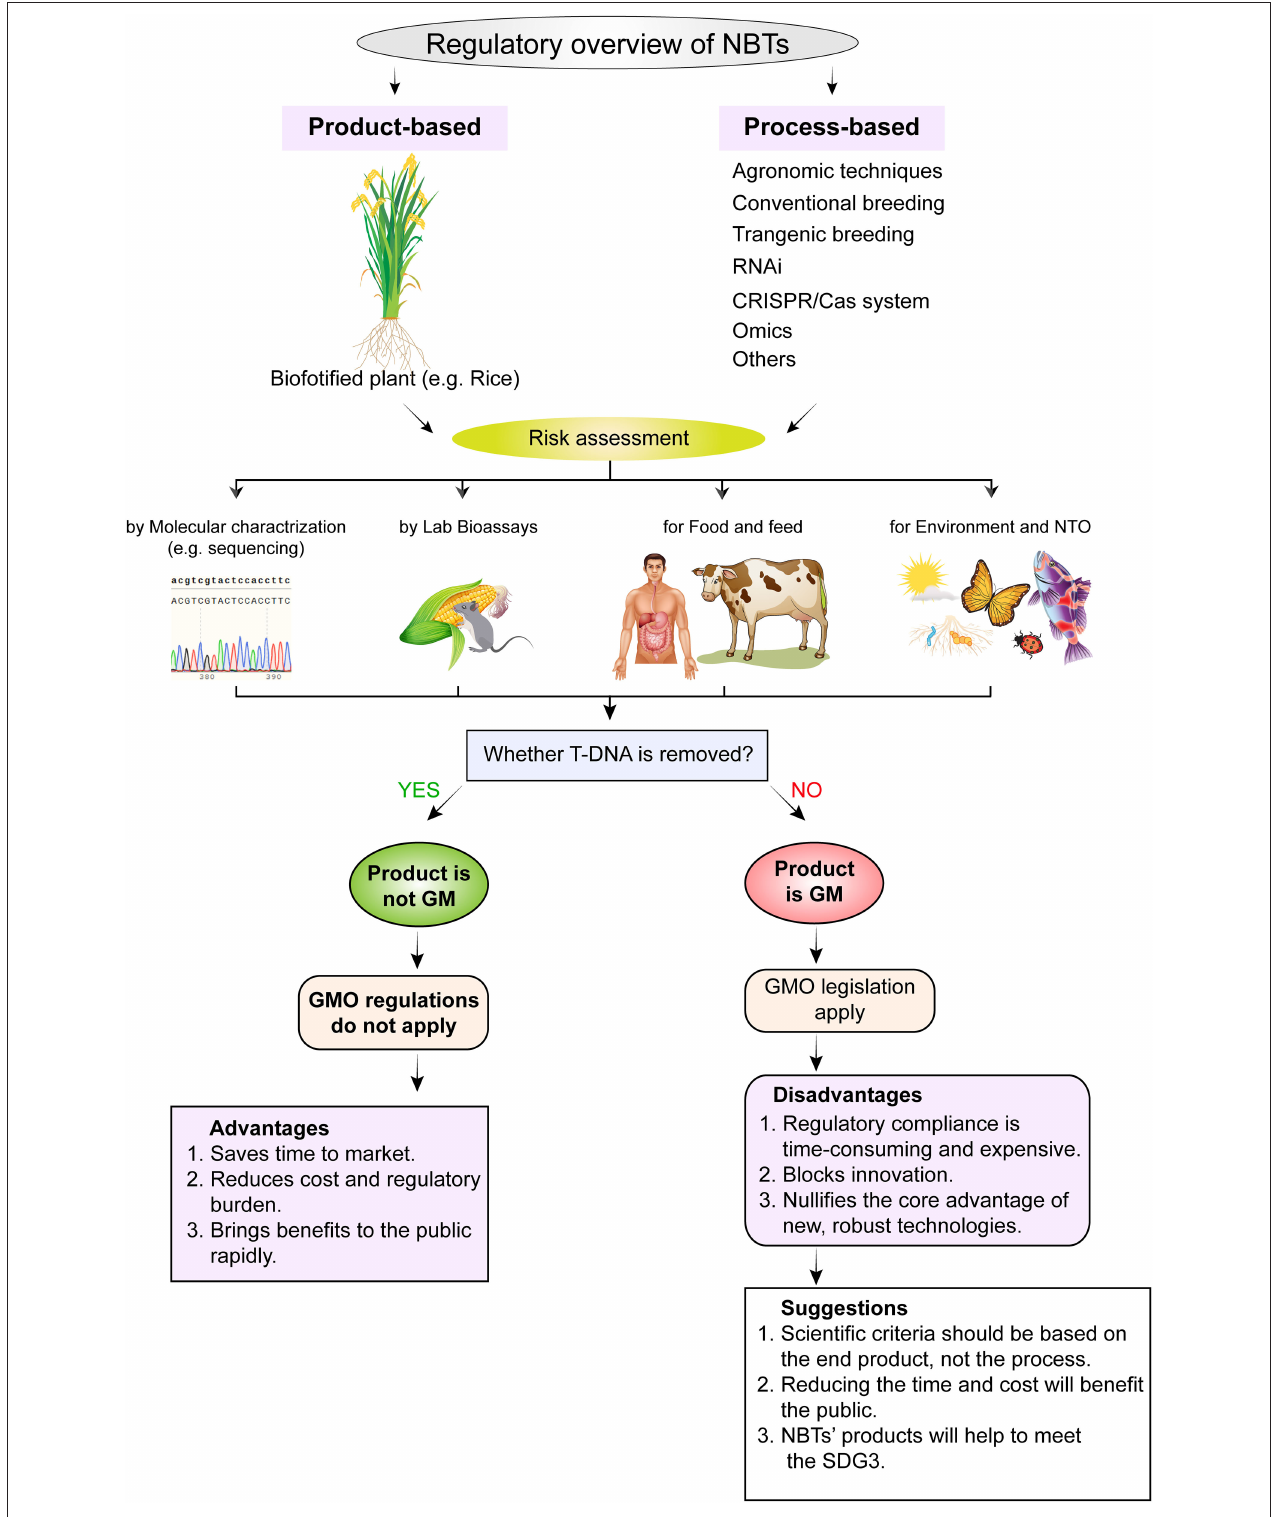
FIGURE 4 | Regulatory framework and risk assessment strategies for commercialization of biofortified crops developed through new breeding techniques (NBTs). The regulatory framework consists of two methods, i.e., process-based regulation and end-product-based regulation. Whereas, risk is assessed by molecular characterization, lab bioassays for food and for environment and NTOs. NTO, non-target organism; T-DNA, transfer DNA; GMO, genetically modified organism; SGD3, sustainable development goal 3.